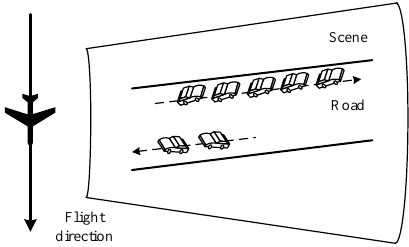
Figure 18. Sketch of the experimental scene.